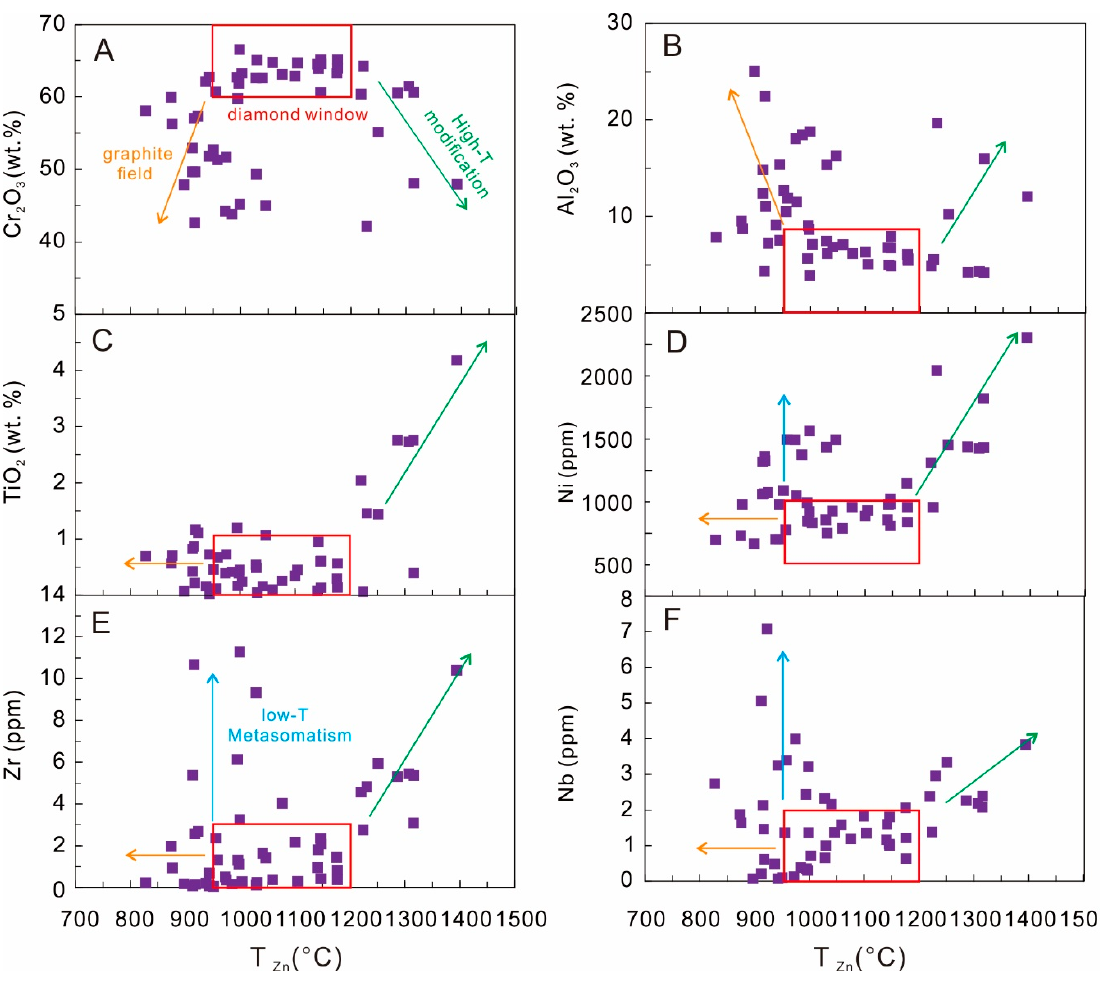
Figure 4. Variations of Cr 2 O 3 ( A ), Al 2 O 3 ( B ), TiO 2 ( C ), Ni ( D ), Zr ( E ), and Nb ( F ) versus T Zn in the cores of the xenocrystic spinels from the No.30 kimberlite. The T Zn are the temperature estimates based on the Zn-in-chromite thermometer [15].